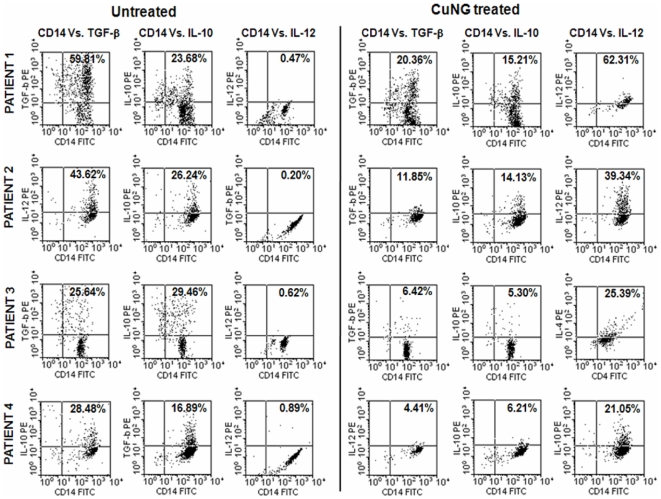
Treatment of CuNG upregulates IL-12 production by adherent population of PBMC from different cancer patients sample.Flow cytometry. PBMC from different cancer patients were isolated and only adherent population was either treated with CuNG (2.5 µg/ml) or kept untreated for 48 hr. Cells was labeled with Abs specific for surface CD14 and intracellular IL-10 or IL-12 or TGF-β and analyzed by flow cytometry.